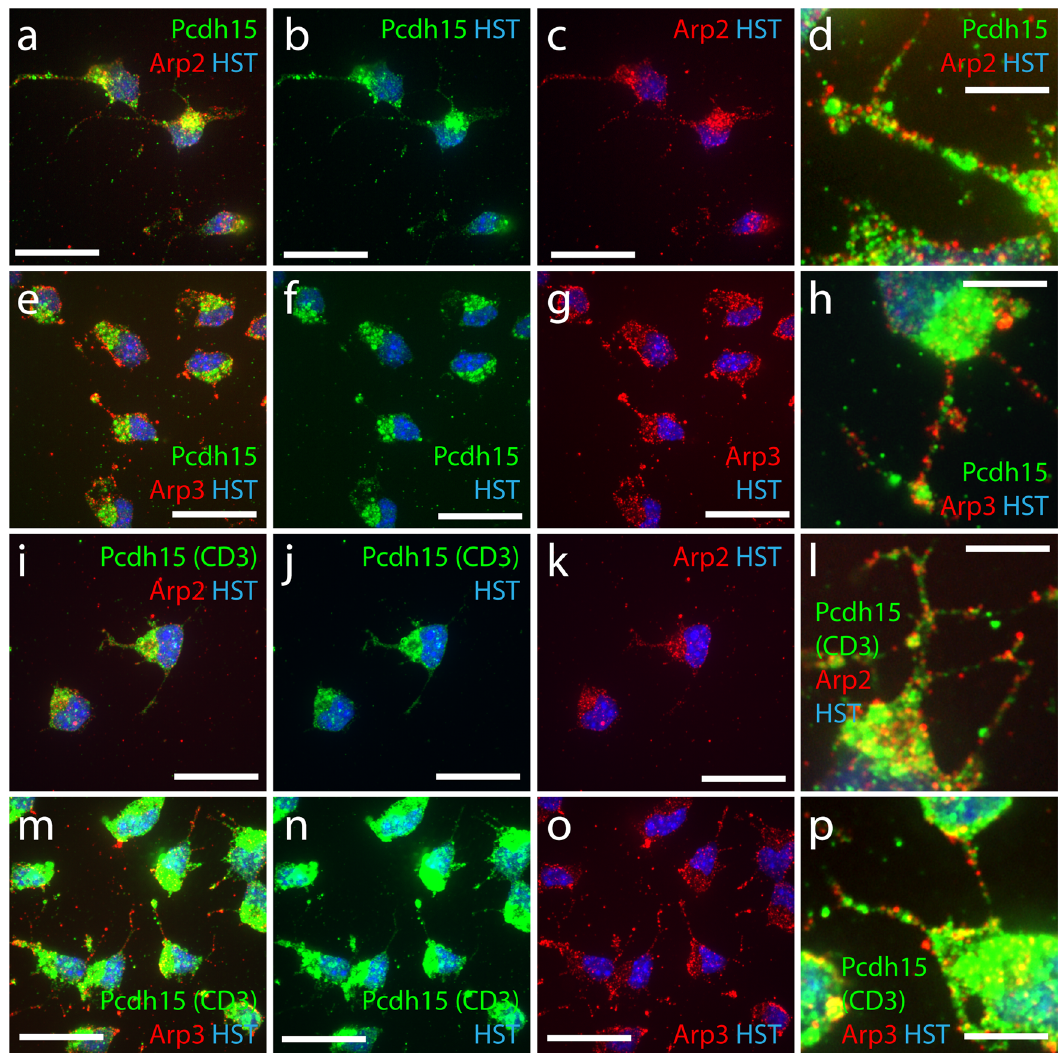
Fig. 8 Primary OPCs express Arp2, Arp3 and Pcdh15 at the soma and throughout the processes. a – c Single z-plane confocal scan of primary mouse OPCs processed to detect Arp2 (mouse anti-Arp2; red), Pcdh15 (rabbit anti-pan Pcdh15; green) and Hoechst 33342 (HST; blue). d Single confocal scan (100×) of primary mouse OPC processes expressing Arp2 (red) and Pcdh15 (green). e – g Single z-plane confocal scan of primary mouse OPCs processed to detect Arp3 (mouse anti-Arp3; red), Pcdh15 (rabbit anti-pan Pcdh15; green) and HST (blue). h Single z-plane confocal scan (100×) of primary mouse OPC processes expressing Arp3 (red) and Pcdh15 (green). i – k Single z-plane confocal scan of primary mouse OPCs processed to detect Arp2 (mouse anti- Arp2; red) and the CD3 isoforms of Pcdh15 (rabbit anti-CD3 Pcdh15; green) and HST (blue). l Single z-plane confocal scan (100×) of primary mouse OPC processes expressing Arp2 (red) and the CD3 isoforms of Pcdh15 (green). (m-o) Single z-plane confocal scan of primary mouse OPCs processed to detect Arp3 (mouse anti-Arp3; red), the CD3 isoforms of Pcdh15 (rabbit anti-CD3 Pcdh15; green) and HST (blue). p Single z-plane confocal scan (100×) of primary mouse OPC processes expressing Arp3 (red) and the CD3 isoforms of Pcdh15 (green). Scale bars represent 20 µ m ( a – c , e – g , i – k , m – o ) or 5 µ m ( d , h , l , p